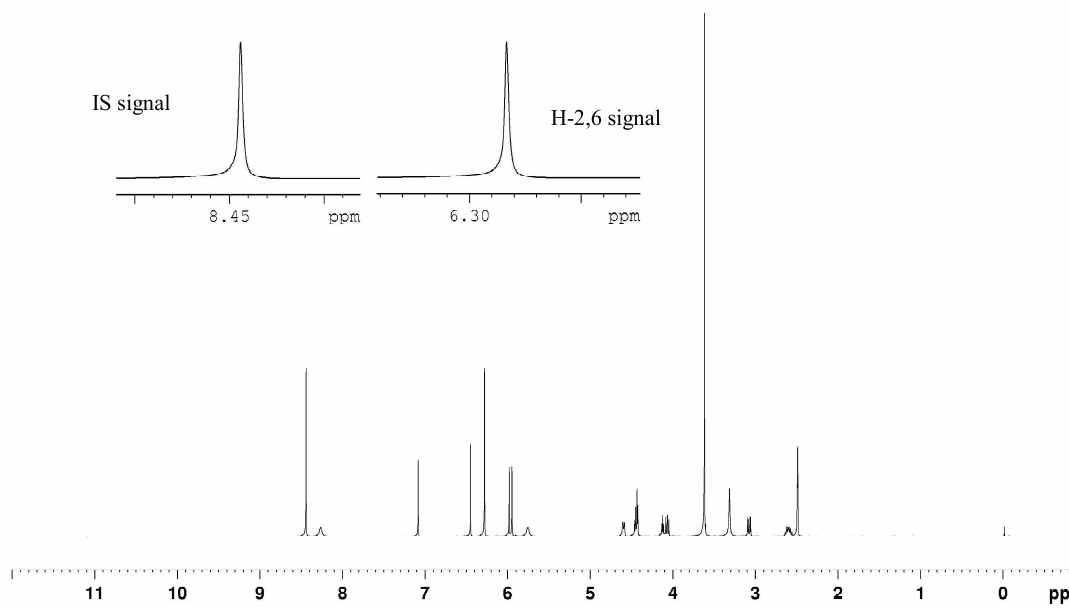
Figure 1. 1 H-NMR spectrum of 4-demethylpodophyllotoxin and 1,4-dinitrobenzene (IS) (500 MHz, DMSO- d 6 ).